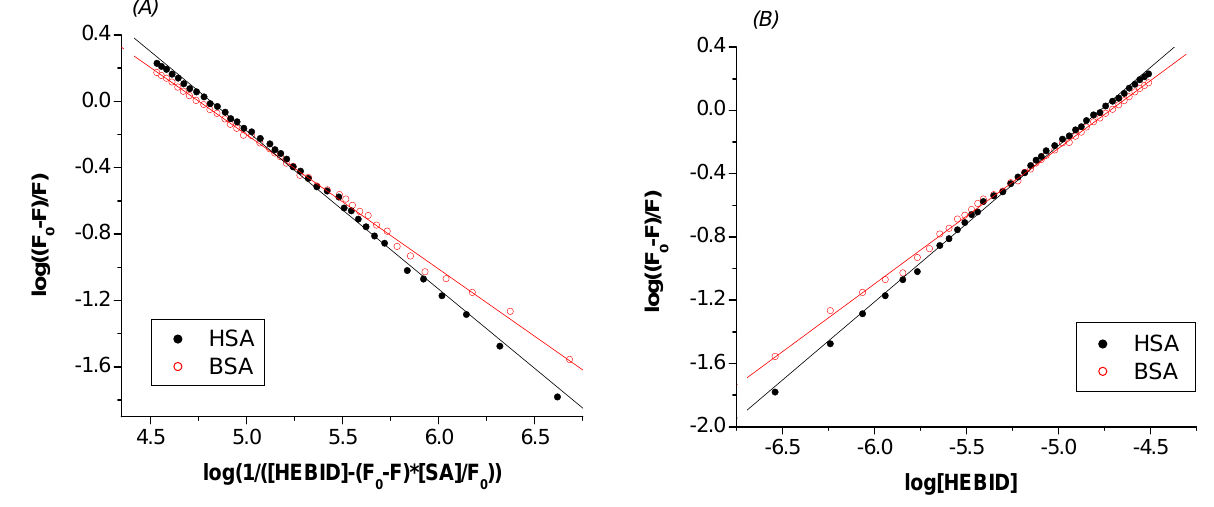
Figure 3 . Plots for the determination of the binding parameters, according to: (A) Equation